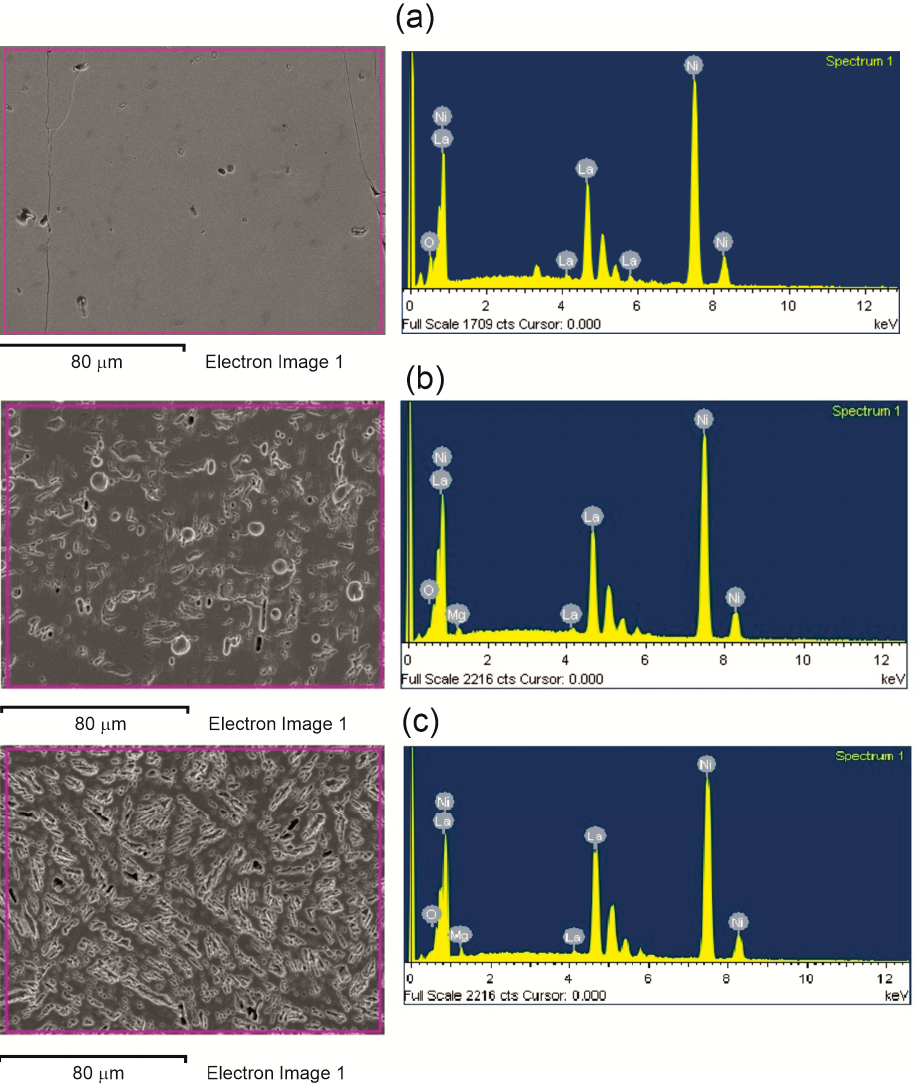
飞过入额 1 Figure 1. Microstructures and EDS analysis results for alloys: LaNi LaNi 4.7 Mg 0.3 ( c